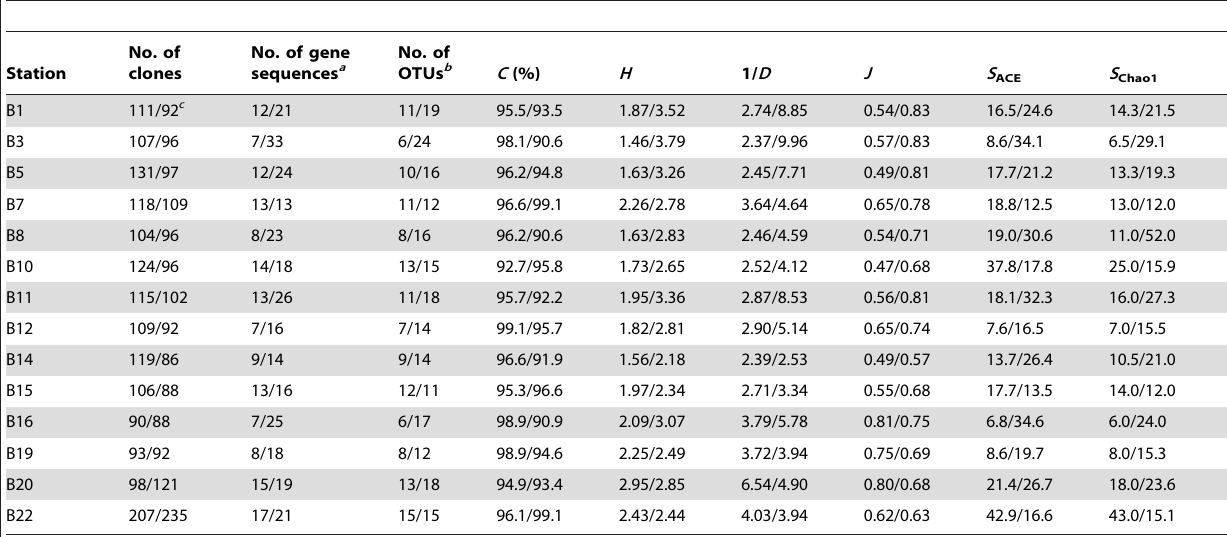
Table 1. Biodiversity and predicted richness of the sediment Scalindua 16S rRNA and anammox hzo gene sequences recovered from the sampling stations of the Bohai